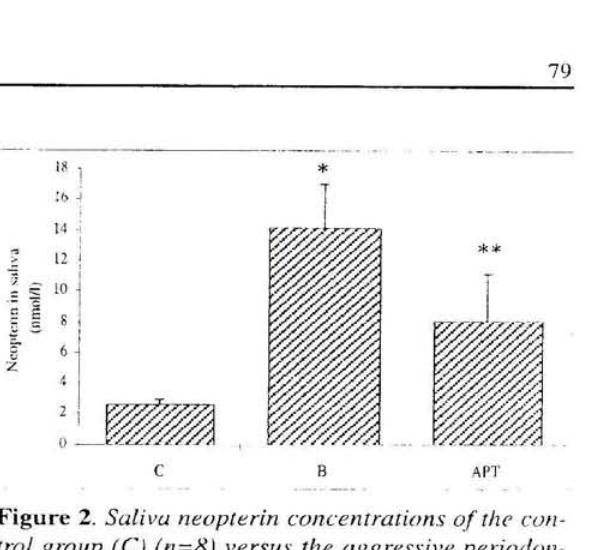
Figure 2. Saliva neopterin concentrations of the con- trol group (C) (n-8) versus the aggressive periodon- titis group (n=8) at the baseline (B) and after the peri- odontal treatment (APT), (Mcan±SEM, *p<0.0i ver- sus C and **p<0.05 versus C, respectively) were Mean neopterin concentrations of patients before treatment and control group in saliva were 14.14 ±